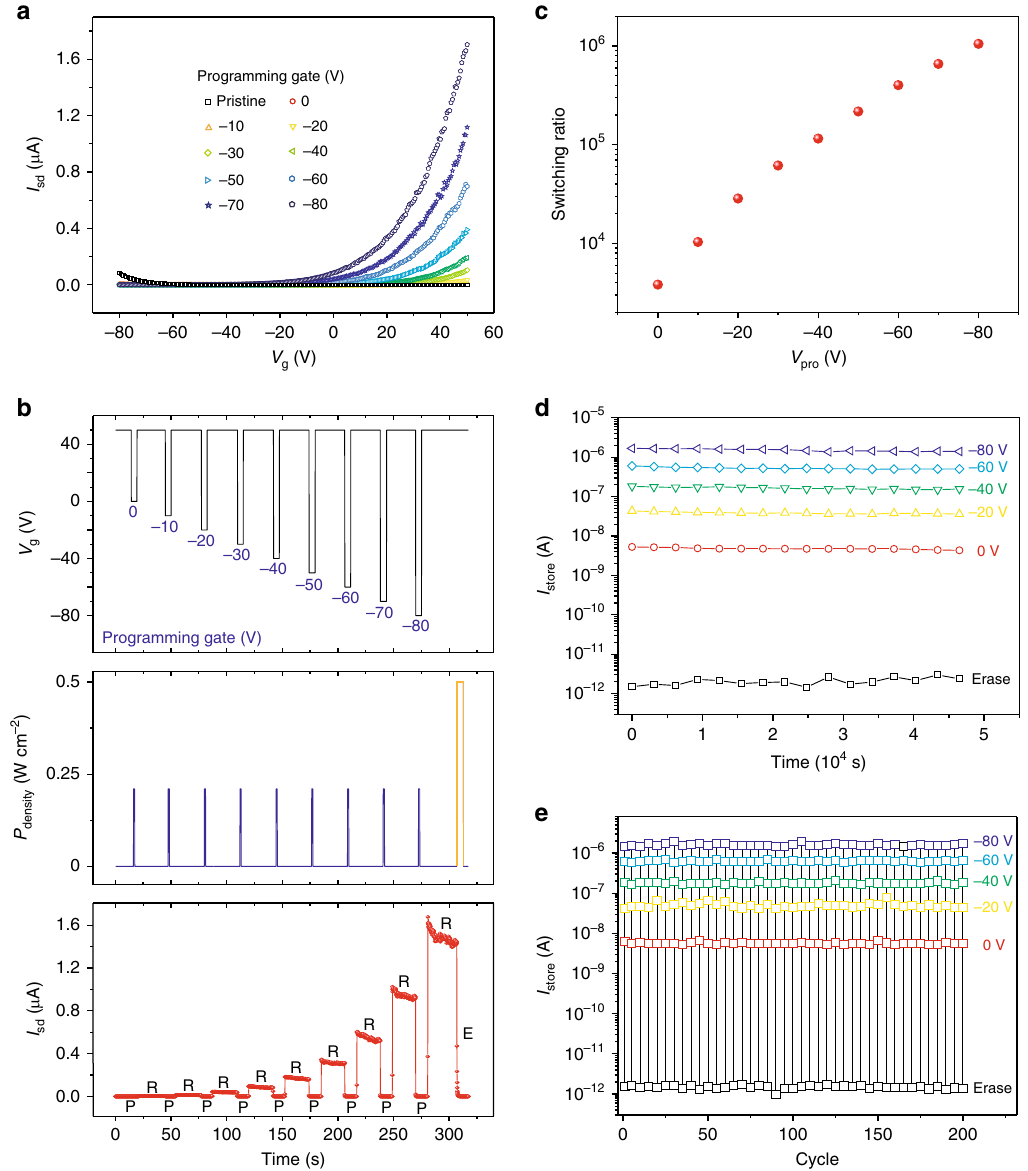
Fig. 2 Programming gate controlled WSe 2 /BN optoelectronic memory and reliability tests. a Transfer characteristics evolution of the memory device with respect to V pro . b Dynamic behavior of the memory at different programming gate ranging from 0 to − 80 V with step − 10 V. The readout current increases stepwise, generating nine clear storage states. c The plot of switching ratio as a function of V pro . Current retention ( d ) and cycling tests ( e ) for the WSe 2 / BN memory at different V pro ( V pro = 0, − 20, − 40, − 60, and − 80 V). The squares in black represent the device in the erased state, while the symbols in red, yellow, green, blue, and purple represent the programmed state under V pro = 0, − 20, − 40, − 60, and − 80 V,